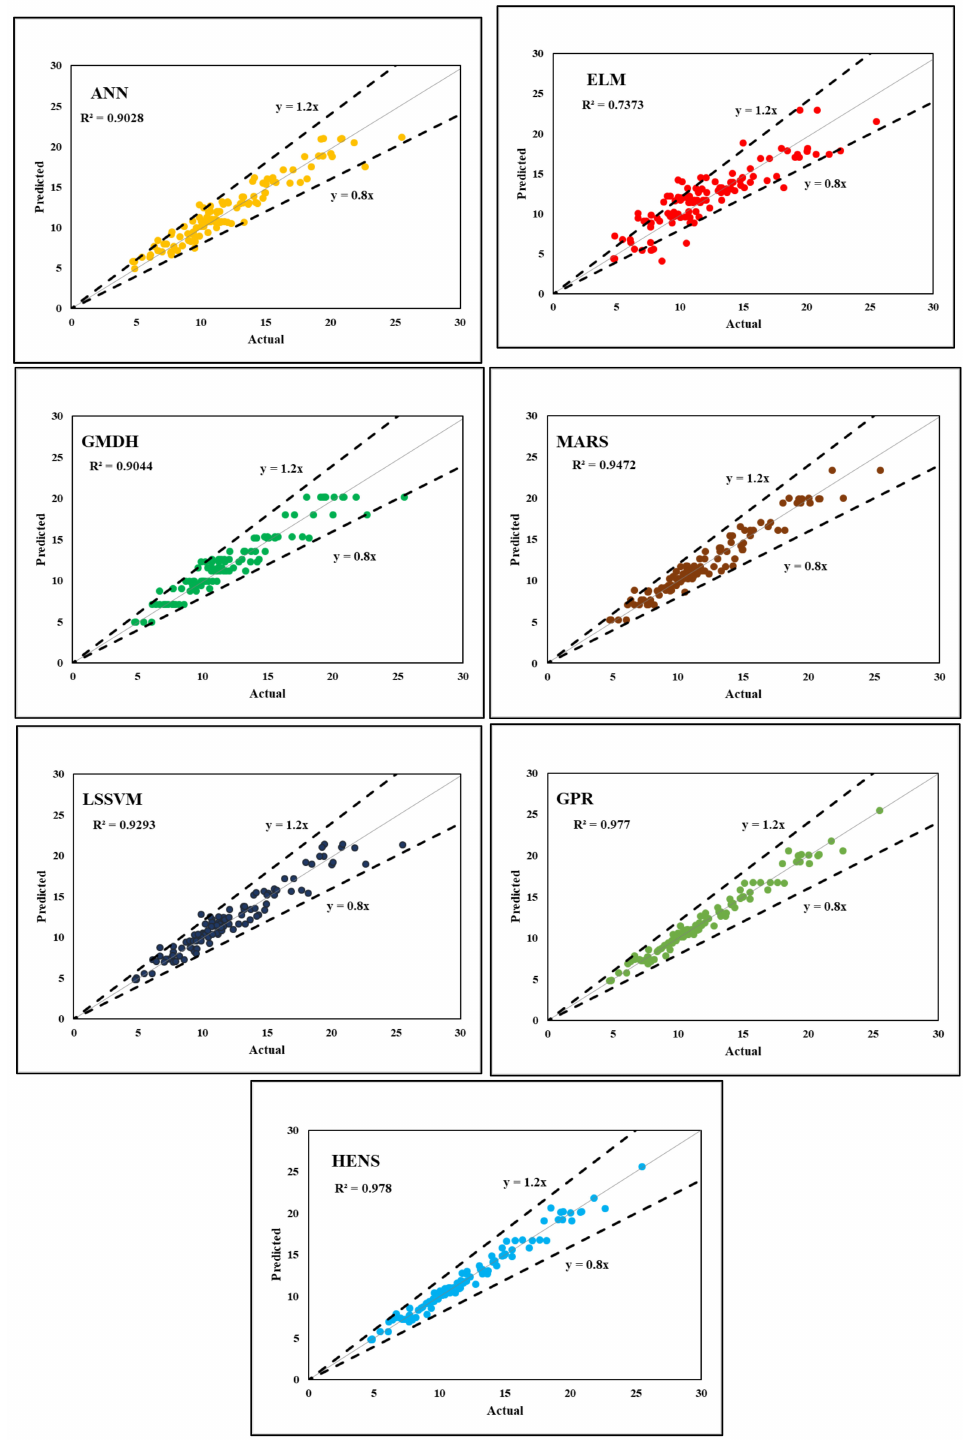
Figure 6. Tested vs. predicted graph of training